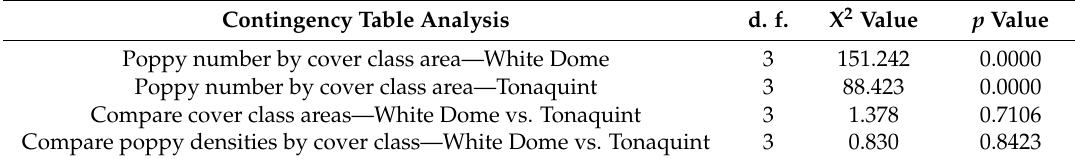
Table 2. Soil surface cover classification and poppy density contingency table ( Χ 2 ) analyses.